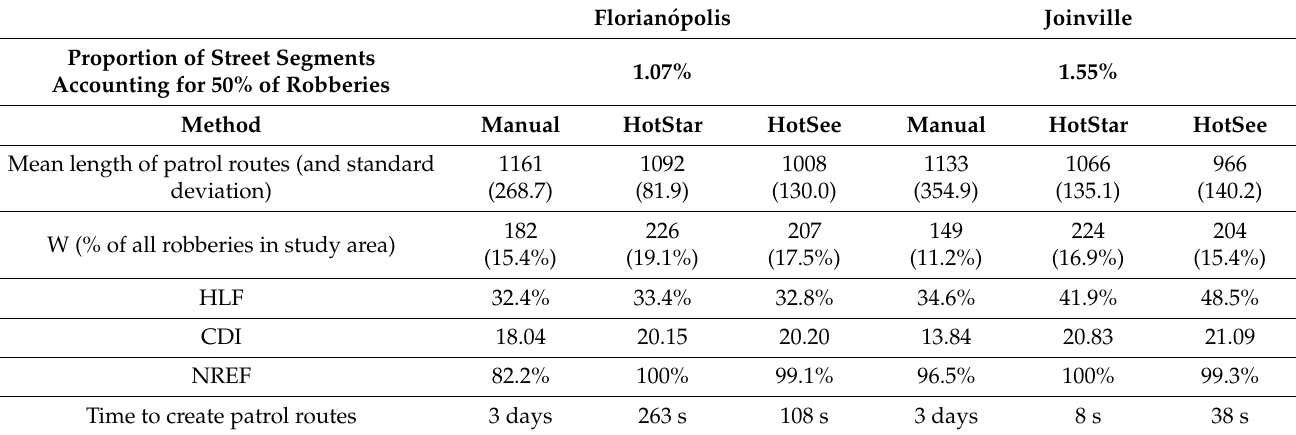
Table 1. A quantitative comparison of the cognitive heuristic and automated spatial computation approaches for the creation of hot spot policing